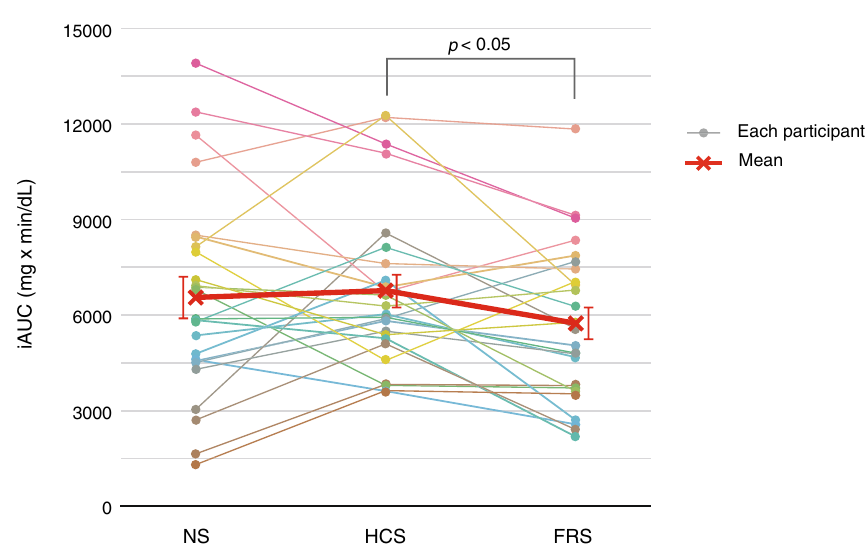
Figure 2. Incremental area under the curve (iAUC) for the three sound conditions for the 25 participants. Red thick line indicates the mean across all participants and error bars indicate the standard error of mean. Colored thin lines indicate each participant’s data. The iAUC was smaller in the full-range sound condition compared with the high-cut sound condition ( P = 0.039 with Holm correction for multiple comparisons).